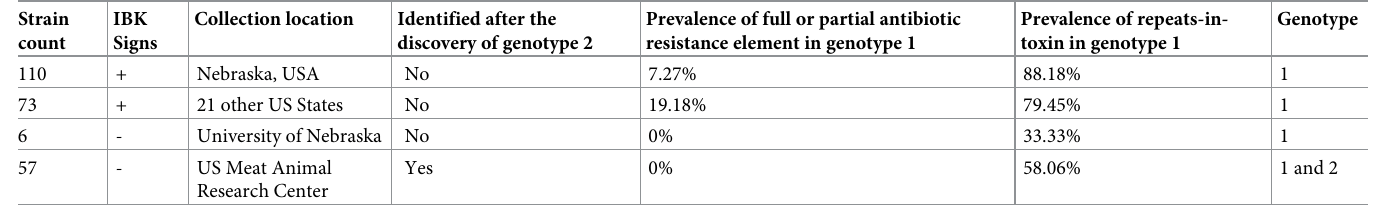
Table 1. Summary of strains included in this